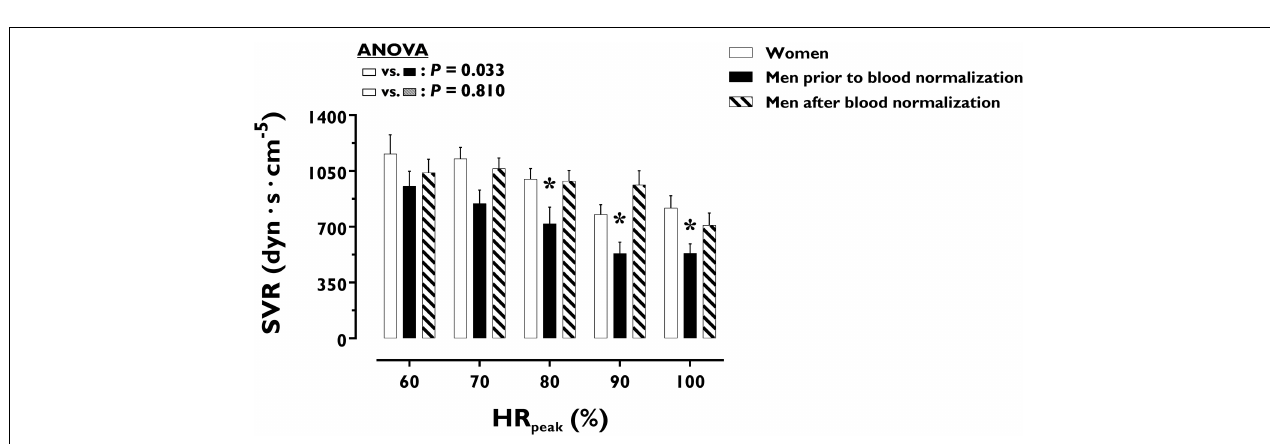
FIGURE 2 | Systemic vascular resistance during incremental exercise in women and men prior to and after blood normalization. * P < 0.05 between women and men prior to blood normalization. † P < 0.05 between women and men after blood normalization. Data are expressed as mean ± SEM. Number of biological observations in the graph: n = 145. Echocardiographic data were analyzed within ± 5 bmp of specific percentages of HR peak . HR peak , peak heart rate; SVR, systemic vascular resistance.